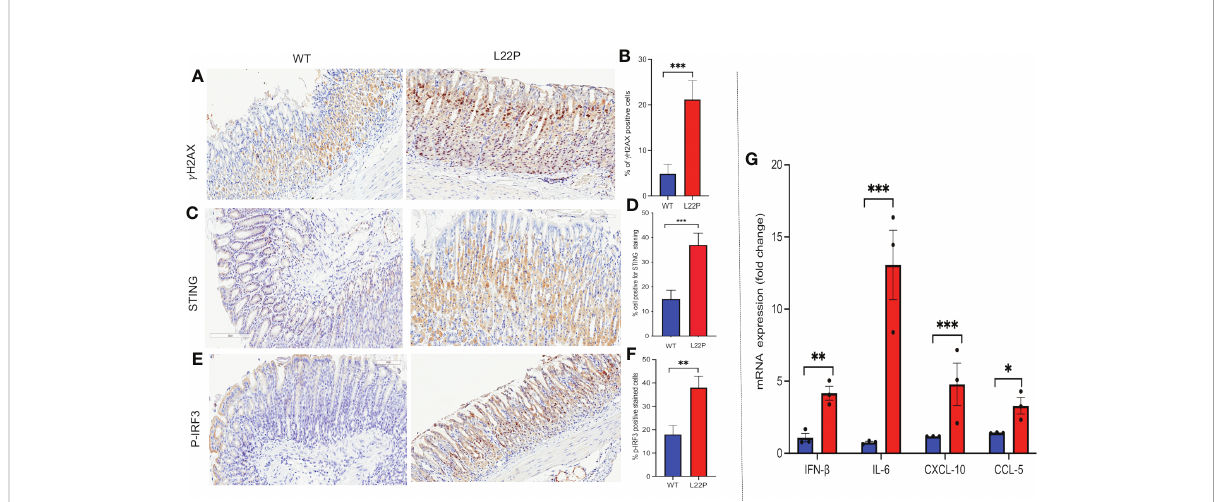
FIGURE 5 cGAS/STING activation in dRP lyase de fi cient mice. (A) Immunohistochemistry staining of stomach tissue section with DSB marker (gH2AX) in dRP lyase de fi cient (L22P) and WT mice; (B) Percentage of cells positive for gH2AX; (C) Immunohistochemistry staining of STING on stomach tissue of dRP lyase de fi cient versus pro fi cient WT mice; (D) Percent of cells positive for STING (E) Immunohistochemistry stain of Ph-IRF3 localization in stomach tissue section of L22P versus WT mice (F) Percent of cells positive for ph-IRF3 (G) Quanti fi cation of mRNA cytosolic DNA-STING signaling mediated cytokines expression using qRT-PCR from stomach tissues derived from dRP lyase de fi cient and pro fi cient WT mice. Data were analyzed using student t-test in GraphPad Prism; P*<0.05, P**<0.01,